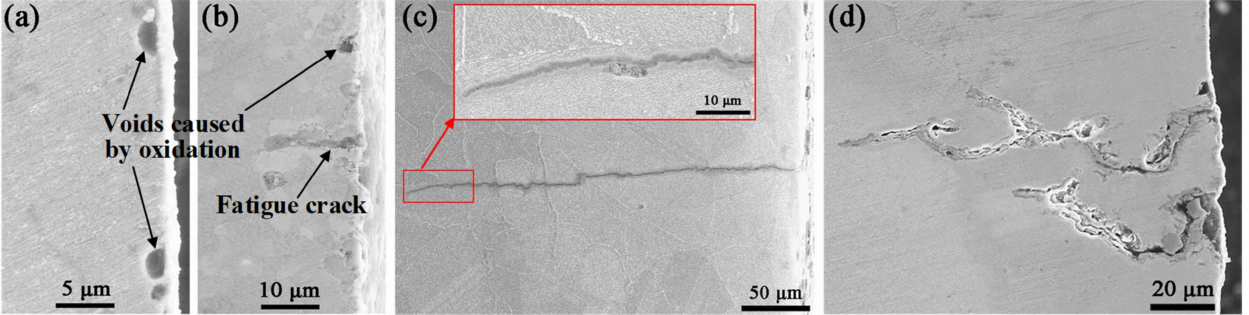
. ε = 1.6 × 10 − 4 s − 1 , ( b , c ) LCF with